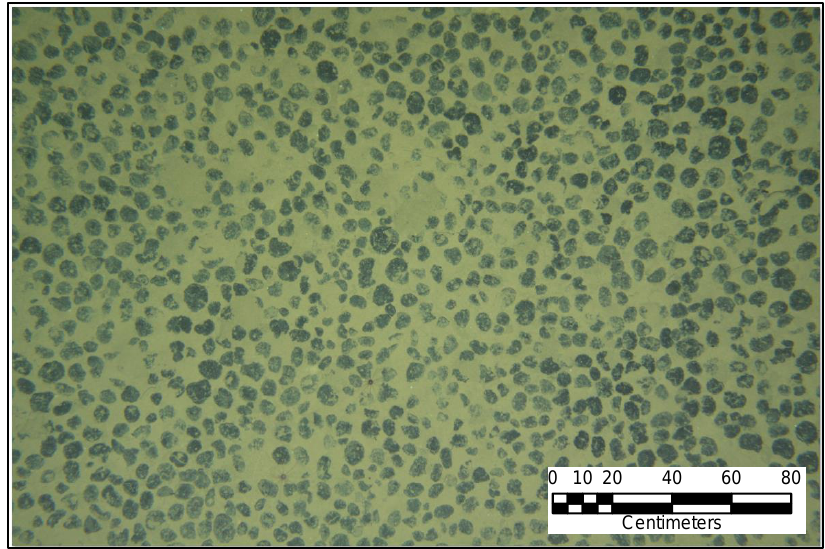
Figure 7. Example of an area with a high abundance of nodules. Source: TOML image